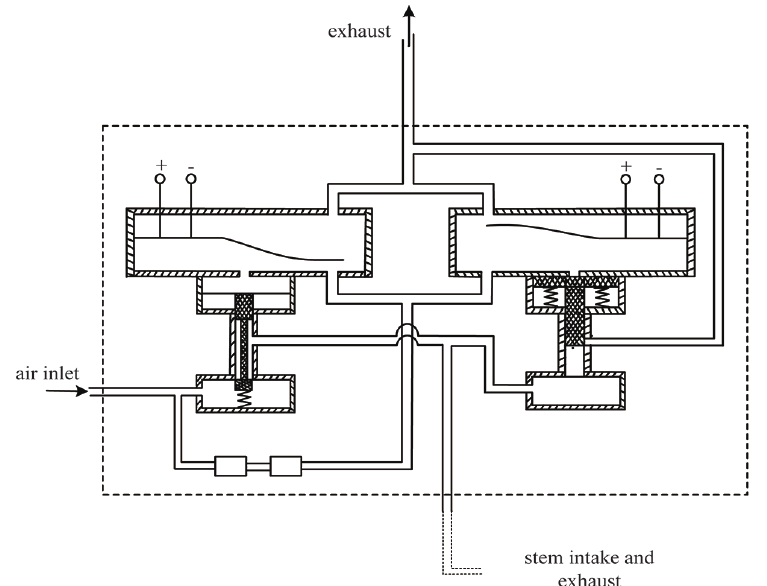
Figure 2. Principle of a piezoelectric air switch